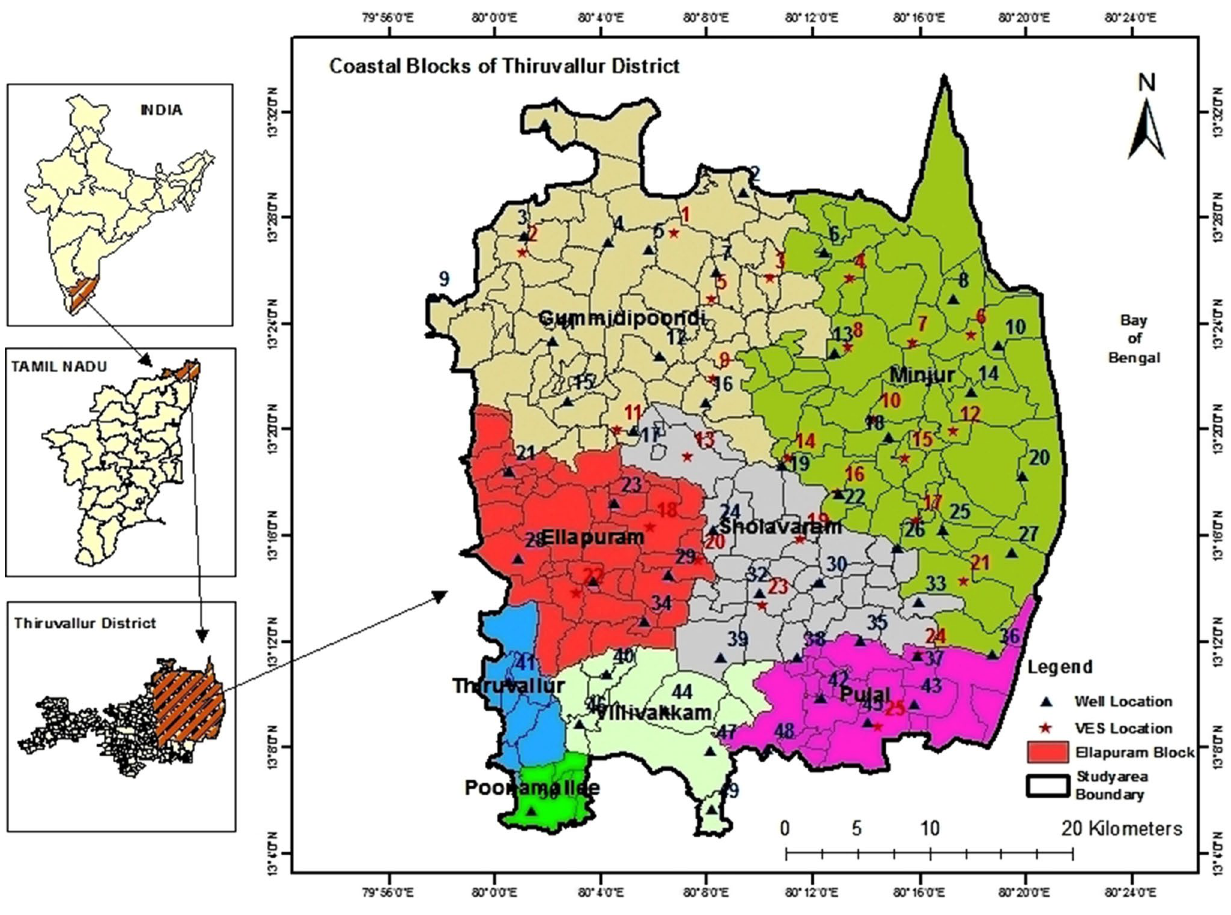
Fig. 1 Location map of the study